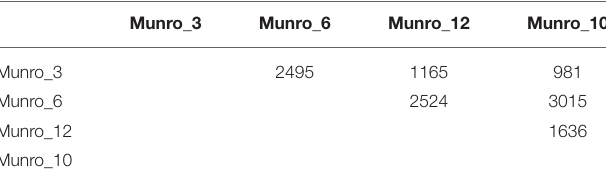
We obtained more than 3.0 million raw tags per library (Table S2). The number of clean tags in each library ranged from 3.03 to 3.34 million. The number of clean tags mapped to transcripts in each library ranged from 2.31 to 2.55 million, accounting for 76.44–76.86% of the total. The number of